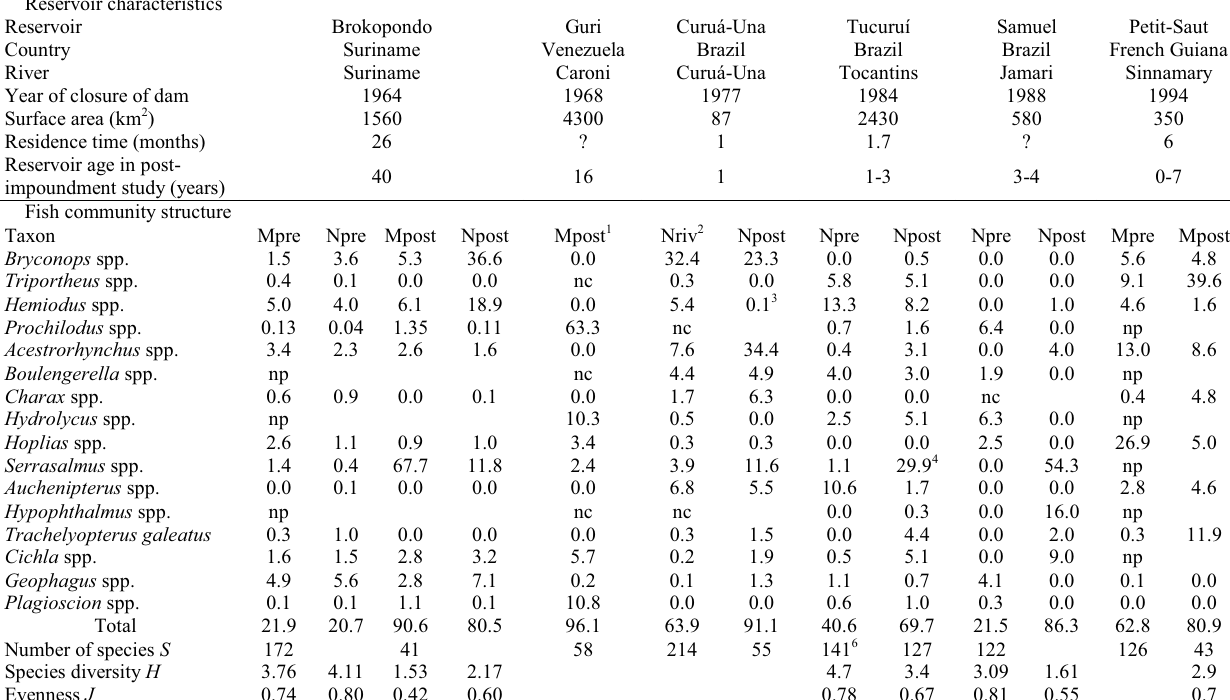
Table 6. Relative abundance in numbers (N, %) and biomass (M, %) of dominant reservoir fishes in pre- and post-impound- ment studies of Amazonian reservoirs; nc = not collected during study; np = not present in pre-impoundment riverine fauna. Source of data: Brokopondo Reservoir (present study), Guri Reservoir (Alvarez et al ., 1986; Novoa et al ., 1991), Curuá-Una Reservoir (Vieira, 1982), Tucuruí Reservoir (Leite, 1993), Samuel Reservoir (Santos, 1995), Petit Saut Reservoir (Tito de Morais & Lauzanne, 1994; Mérona et al ., 2003).No data are available of the fish fauna in the Guri Reservoir area before closure of the dam 1 . No pre-impoundment data for Curua-Una dam are available; presented are data of the fish fauna of the Curua-Una River up- and downstream of dam 2 . Later in time (1982-1983), Ferreira (1984) found Hemiodus spp together with Auchenipterus and Serrasalmus dominant in number of specimens in Curua-Una Reservoir 3 . Piranha species in Tucuruí Reservoir included the redbelly piranha Pygocentrus nattereri 4 . Santos et al. (1984) indicate a total number of 300 species collected by diverse gears in Tocantins River 5 .